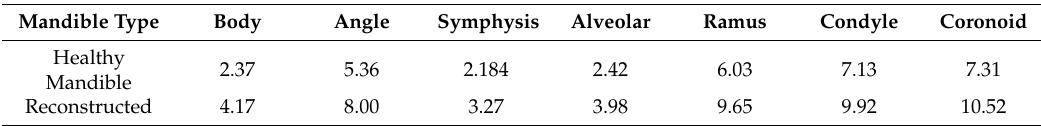
Table 5. Average von Mises stress in different regions obtained from finite element analysis of the healthy mandible vs. the reconstructed mandible